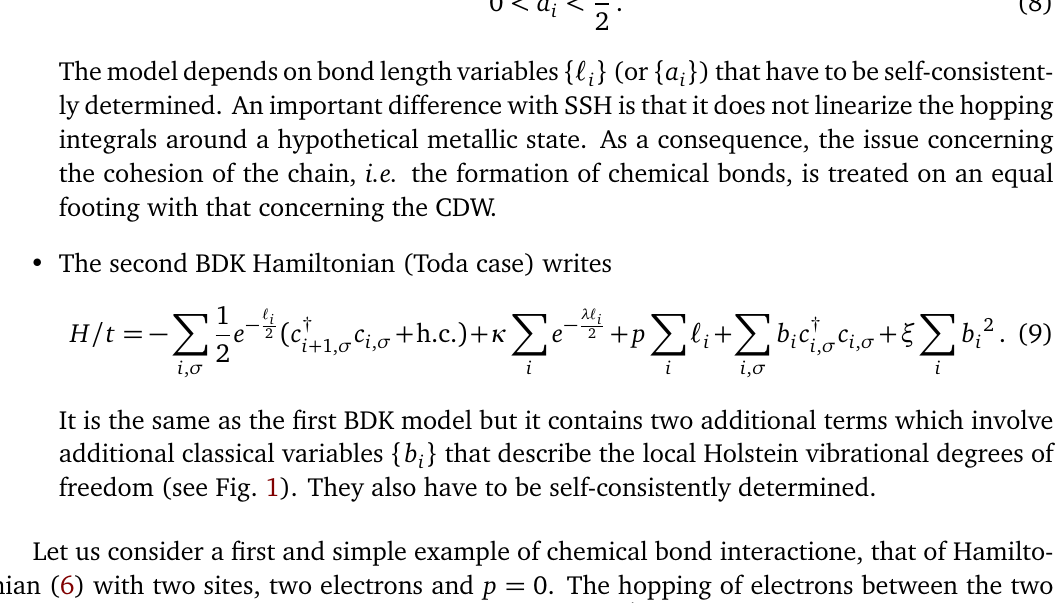
Figure 2: Two-body energy (Eq. 10). It has a minimum at ℓ = ℓ length of an isolated covalent